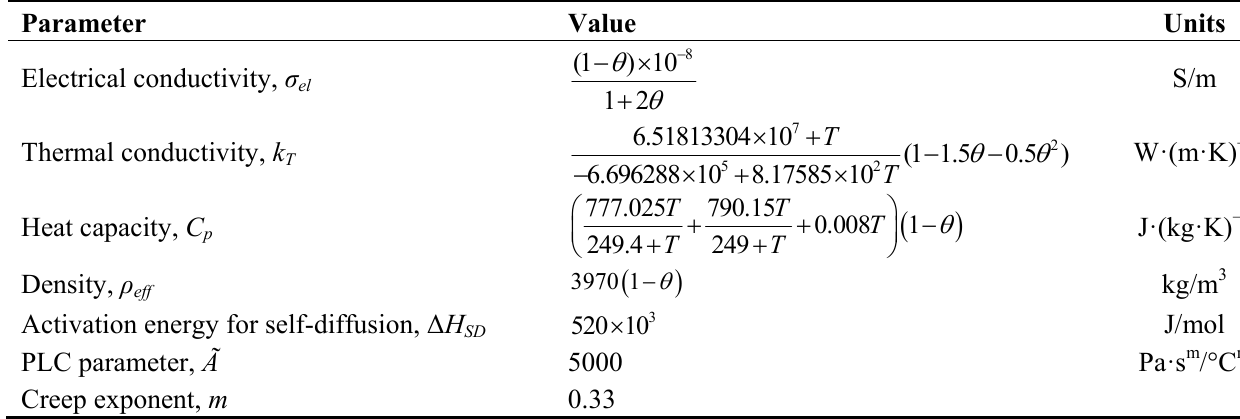
Table 3. Alumina properties— T , K